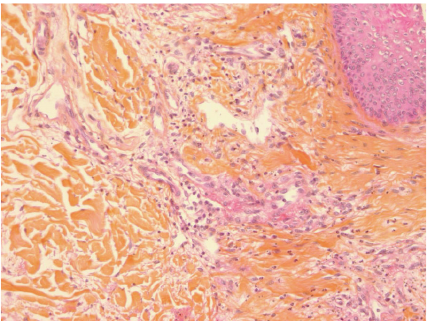
Figure 3: Skin biopsy showing leukocytoclastic vasculitis and intravascular